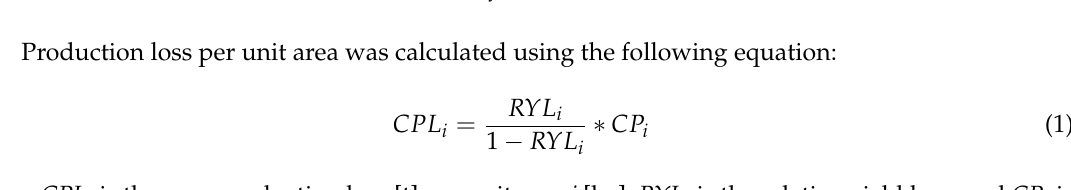
Table 1. Exposure–response functions for the four crops of economic interest analyzed in this work in the city belt of Central Mexico [12]. AOT40: accumulated exposure over the threshold of 40 ppb. Crop ERFs Used for RYL Calculation, AOT40 [ppm · h] Critical Level * [ppm · h] Maize − 0.0035 * AOT40 13.9 Sensitive crops (oats, sorghum, and beans) * For 5% yield